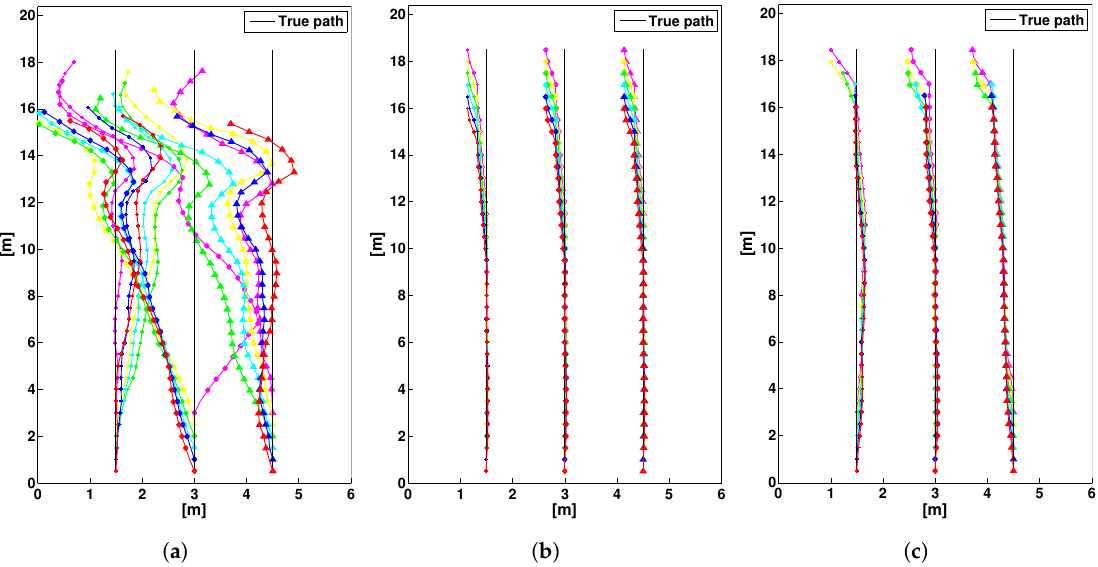
Figure 14. Trajectories of 18 users by cooperative and non cooperative processing. Each marker and color combination uniquely represents a user. Black lines indicate the true trajectories. Each trajectory is covered by a group of 6 users that are walking vertically aligned, as indicated in Figure 12. The estimates are represented by colored markers, with a different color for each user and a different marker for each of the 3 trajectories. ( a ) Conventional PDR; ( b ) MPD & CDF; ( c ) MPD & DDF